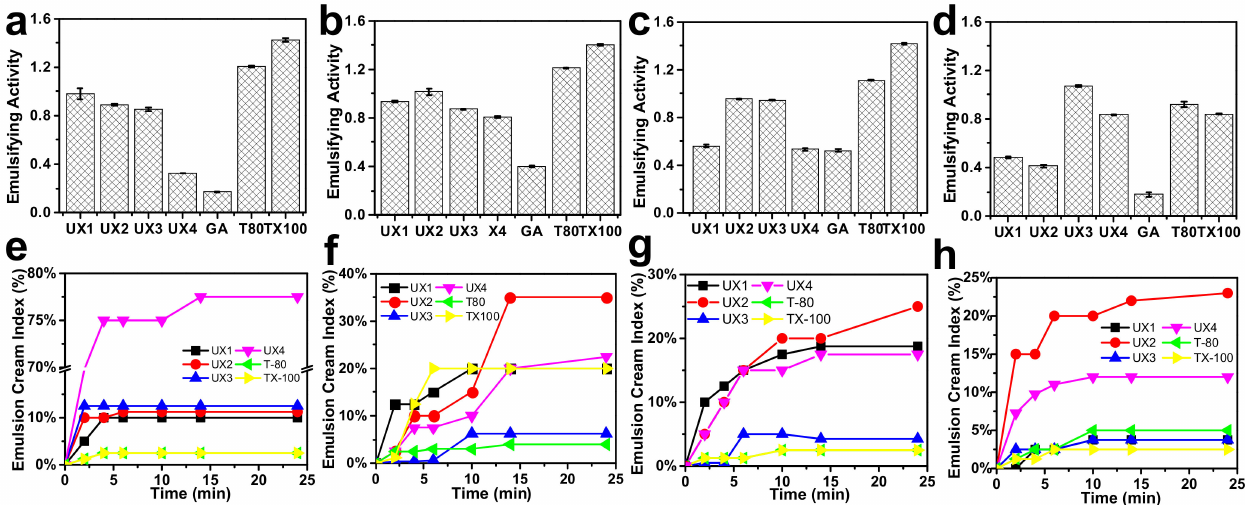
Figure 4. Emulsifying activity ( a – d ) and emulsion cream index after centrifugation ( e – h ) at 0.5, 1, 2, and 4 wt% emulsifier